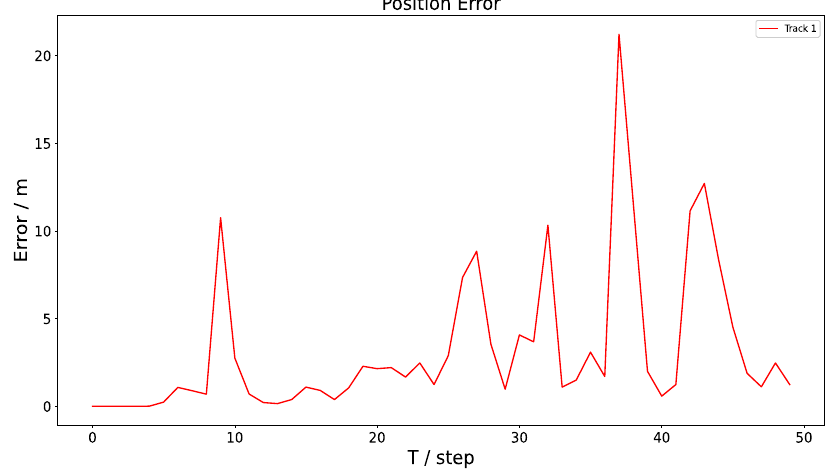
Figure 15. Tracking error between prediction and actual track (CMKF-REMTT).